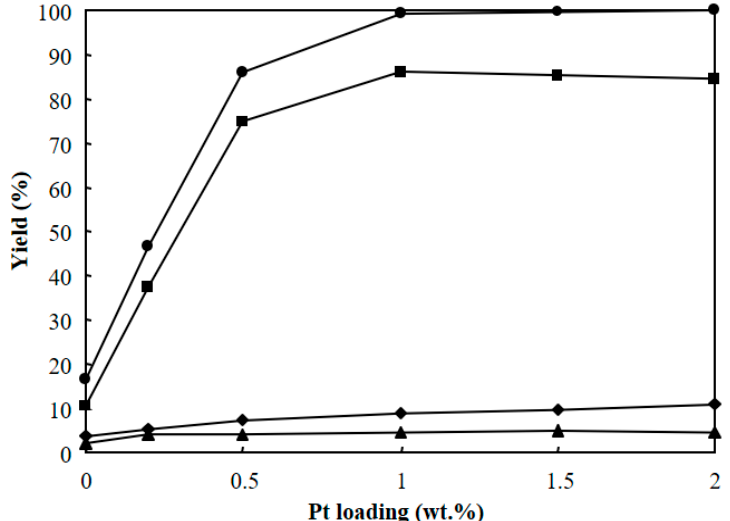
Figure 8. E ff ect of Pt loading in Pt / Al / MCM-48 for the hydrocracking of polyethylene at 573 K for 4 h. Figure 8. Effect of Pt loading in Pt/Al/MCM-48 for the hydrocracking of polyethylene at 573 K for 4 h. ( • ): total yield of C 1 –C 21 , ( (cid:7) ): C 1 –C 8 yield, ( (cid:4) ): C 9 –C 15 yield, ( (cid:78) ): C 16 > –C 21 ( ● ): total yield of C 1 ‒ C 21 , ( ♦ ): C 1 ‒ C 8 yield, ( ■ ): C 9 ‒ C 15 yield, ( ▲ ): C 16 ‒ C 21 yield.